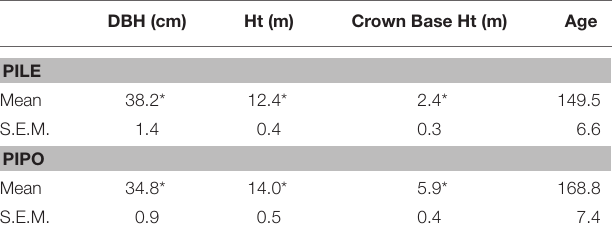
TABLE 1 | Individual tree summary